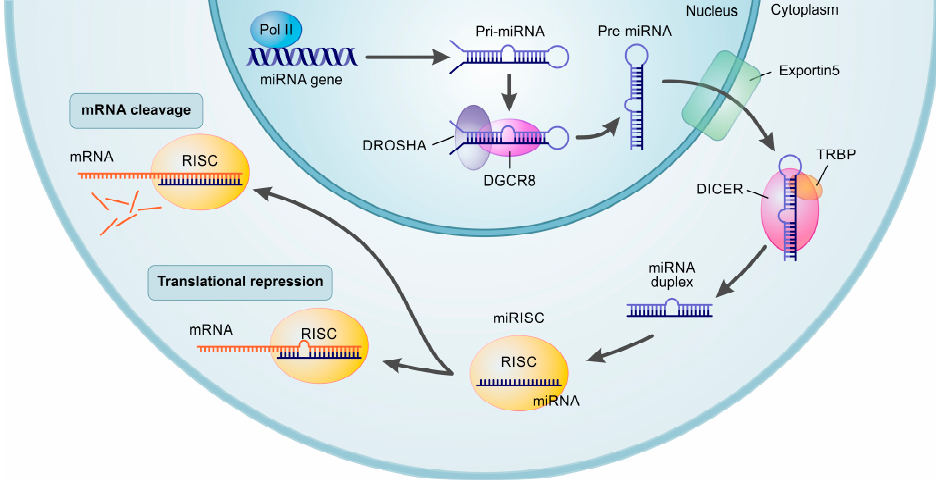
Figure 1. miRNA biogenesis and function.